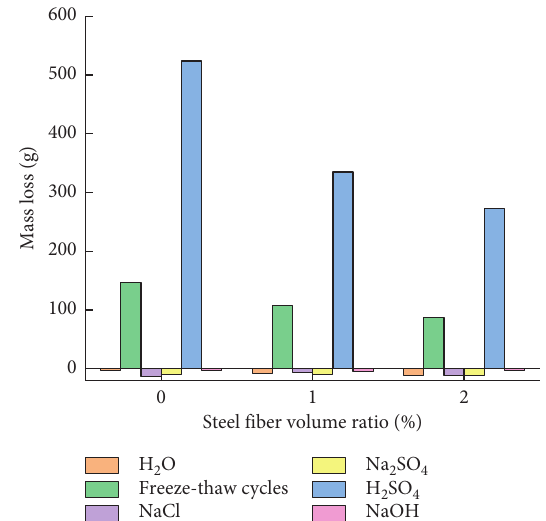
Figure 11: Comparison of mass loss after environmental